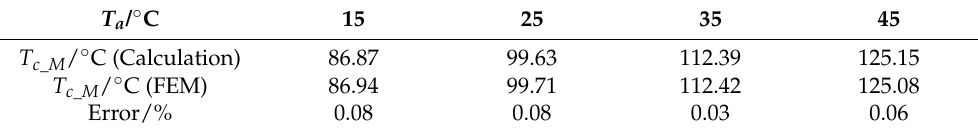
Table 6. The junction temperature comparisons of the calculation and simulation for the MOSFET.